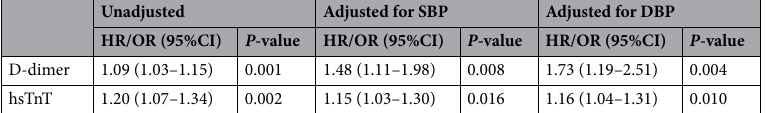
Table 4. Unadjusted and blood pressure adjusted associations of 1 SD increase of D-dimer and hsTnT with all-cause mortality.